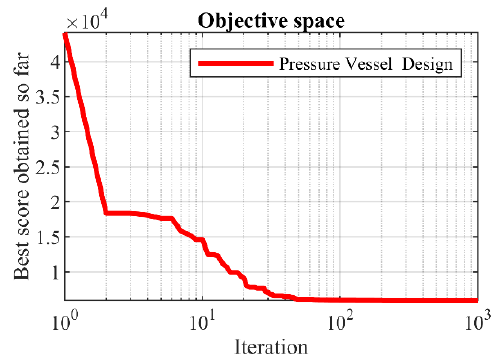
21 of 30 Table 10. Statistical results for a pressure vessel design problem. Algorithm Best